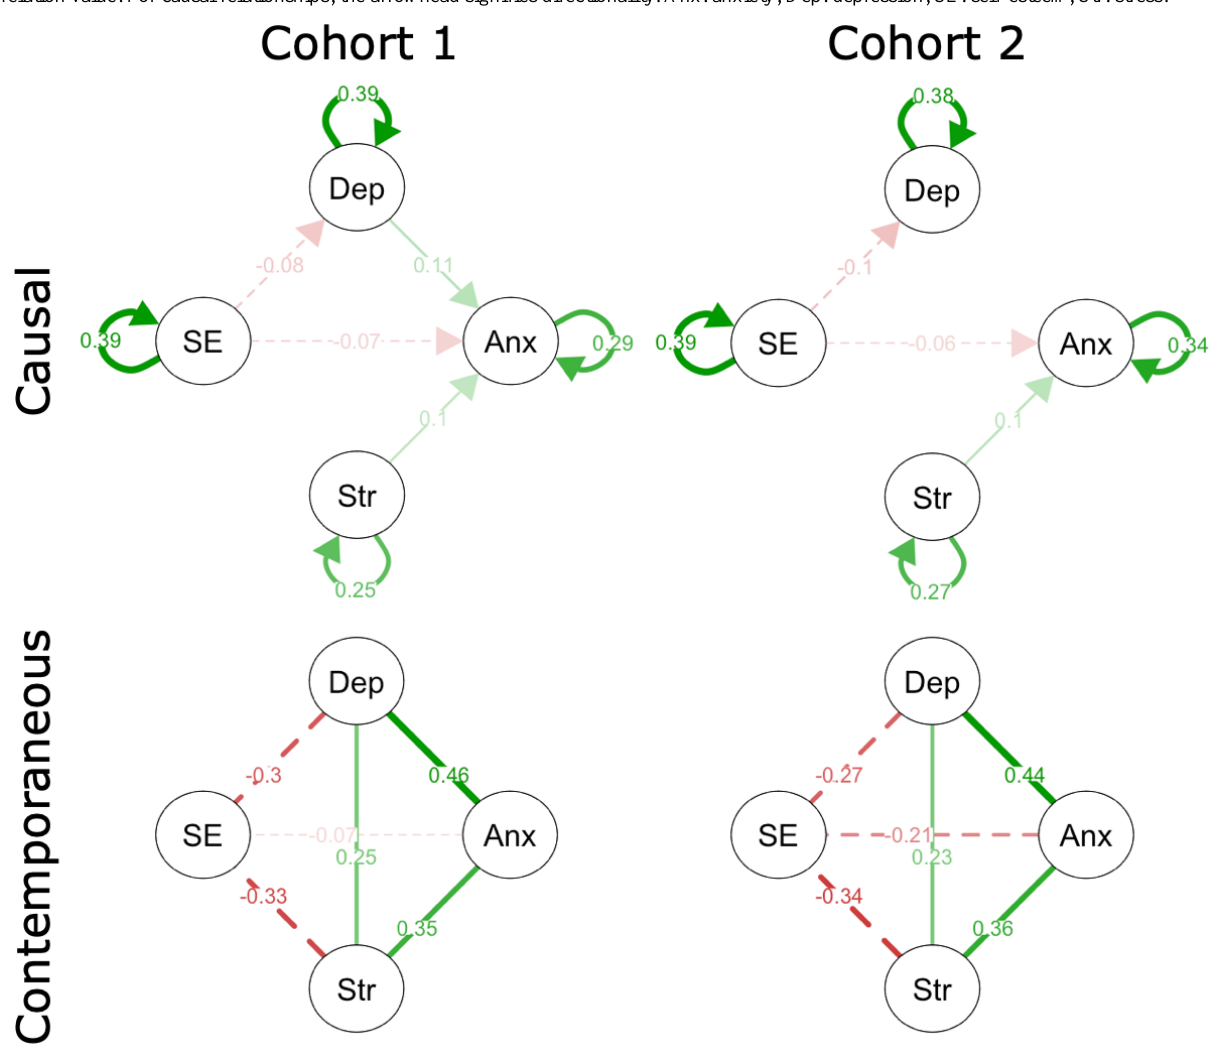
Figure 1. Causality graph observing previous week (t-1) connections on mental health metrics collected through ecological momentary assessments weekly for cohorts 1 (top left) and 2 (top right) at a threshold of P <.005. Contemporaneous connections presented for cohorts 1 (bottom left) and 2 (bottom right). Solid lines are positive relationships and dashed lines are negative relationships with magnitude marked on the graph, listing the partial correlation value. For causal relationships, the arrowhead signifies directionality. Anx: anxiety; Dep: depression; SE: self-esteem; Str: